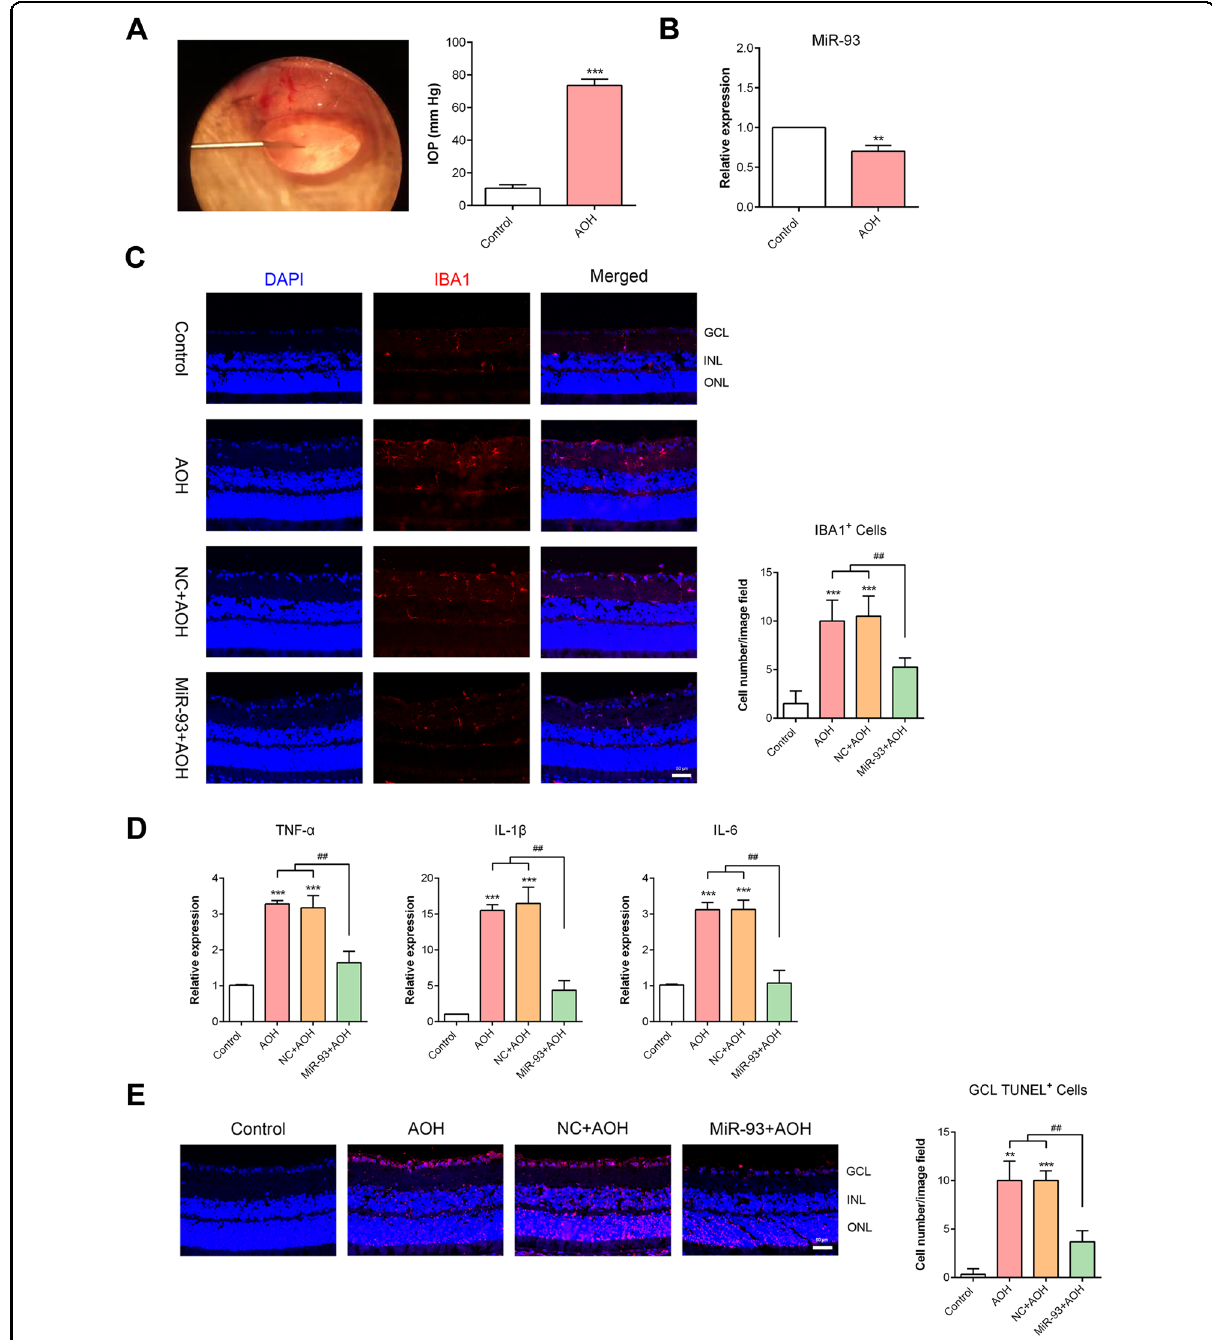
Fig. 1 MiR-93 regulated retina microglial activation and neuronal apoptosis in AOH injury. A Rat acute ocular hypertension model. As the infusion needle was placed into the anterior chamber of the rat eye, IOP was rapidly elevated and maintained for an hour. B The miR-93 level was signi fi cantly decreased in AOH retinae versus controls. C Retinal microglial reaction in the AOH model. More microglia cells co-labelled with IBA1 (red) and DAPI (blue) were shown in retinae of AOH model, changed cell shape and migrated to the ganglion cell layer. MiR-93 upregulation suppressed microglial activation, as shown by fewer cells compared to the number in AOH retinae, while NC injection alone did not have any obvious in fl uence. D QRT-PCR showed much higher cytokines expression in the retinae exposed to AOH injury. However, miR-93 overexpression in the eyes signi fi cantly ameliorated retinal neuroin fl ammation compared with that in AOH and NC + AOH eyes. E As measured by TUNEL staining, the apoptosis of retinal cells was noticeably increased in response to AOH injury. Intravitreal miR-93 rescued retinal GCL cells from AOH-induced damage. Compared with the control: ** P < 0.01, *** P < 0.001. Compared with the AOH and NC + AOH group: ## P < 0.01. n = 3 retinae. NC + AOH, agomir negative control + AOH; miR-93 + AOH, miR-93 agomir + AOH; GCL ganglion cell layer, INL inner nuclear layer, ONL outer nuclear